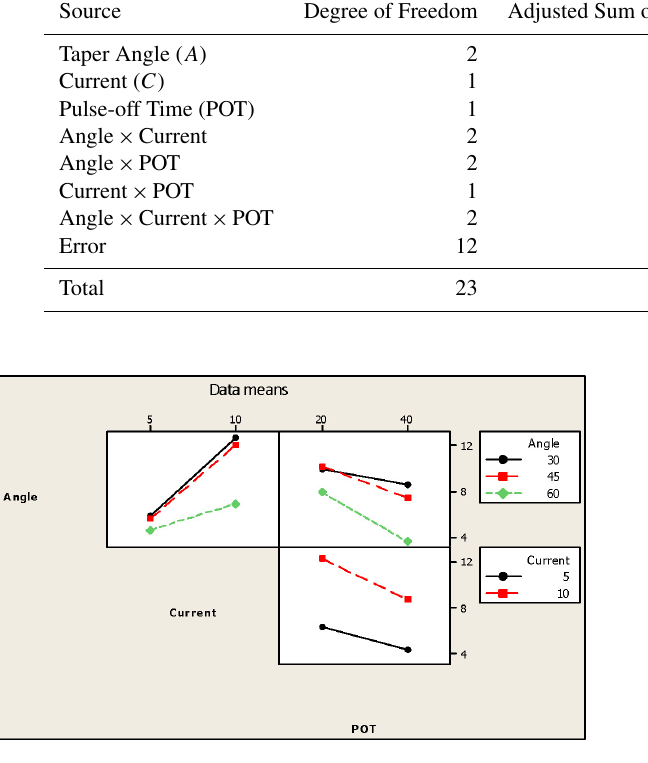
Figure 10. Interaction effect plots of Mean MRR. Figure 11. Main effect plots of mean wire